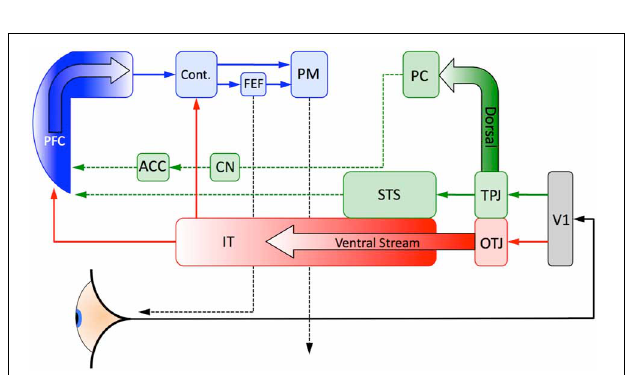
FIGURE 3 | A feedforward schematic of how percepts of intermediate complexity either excite or inhibit more complex percepts. C 1 and C 2 are neurons that encode high order scene categories that are composed of percepts of an intermediate complexity. (A) A conceptual framework of cell assemblies that act to excite and/or inhibit more complex categorical representations. The groups of neurons E 1 , E 2 , I 1 , and I 2 are each a set of neurons some of which have overlapping functionality between excitation